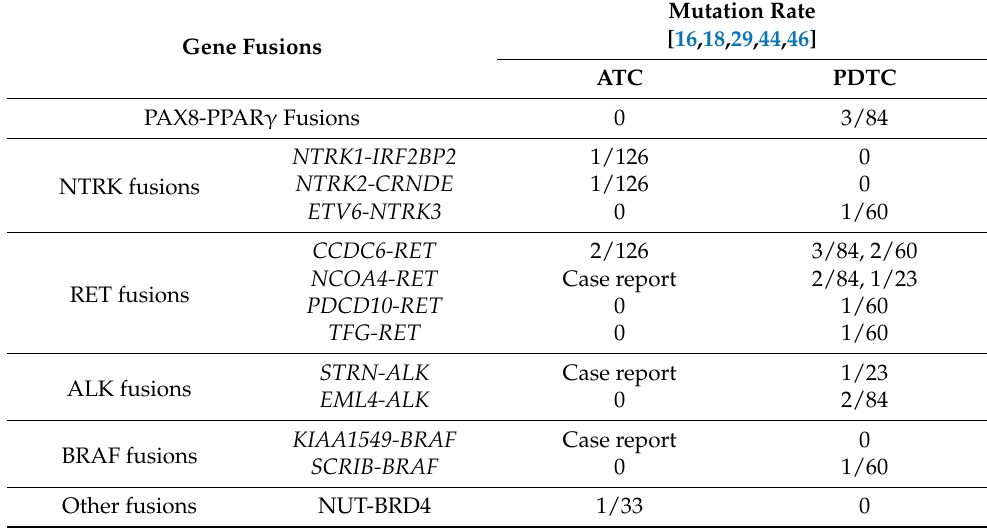
Table 2. ATC and PDTC genetic landscape: gene